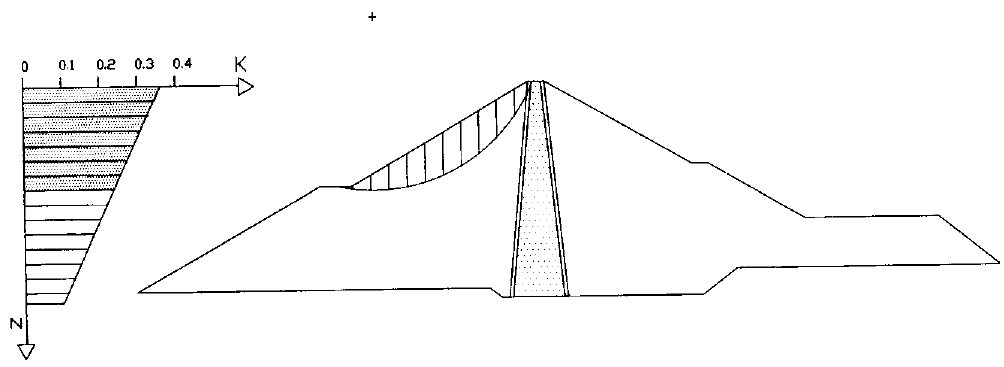
Fig. 7. Sliding surface adopted in the Newmark analysis for the upstream shell of the El Infiernillo Dam.